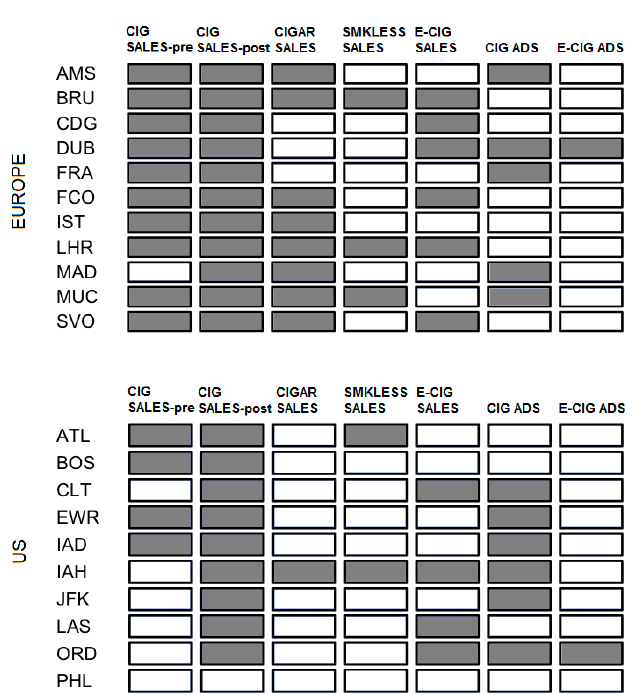
Figure 1. Presence of TAPS in airports in Europe and the US observed in either pre- or post-security locations, 2014 *.